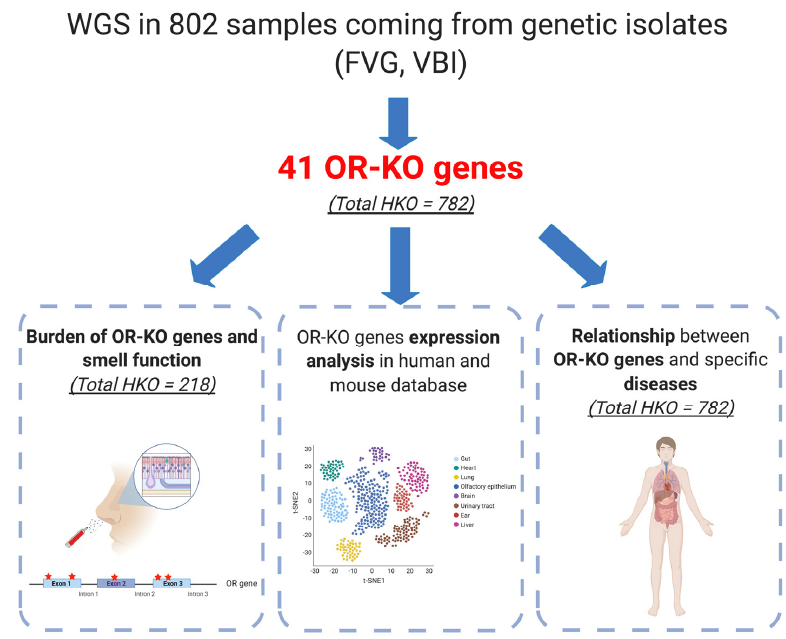
Figure 1. Workflow of the study. The picture summarizes the general workflow applied in the present study. Briefly, whole genome sequencing (WGS) data of 802 samples have been checked, searching for olfactory receptors (OR) genes carrying loss of function (LoF) variants. Data analysis led to the identification of 41 OR-KO (Olfactory Receptor knockout) genes in 782 subjects. Among those individuals, Sniffin’ Sticks test data were available for a total of 218 persons. The association between the burden of OR-KO genes and odor discrimination was tested, together with the analysis of OR-KO genes’ expression in human and mouse tissues and the correlation between OR-KO genes and specific diseases.